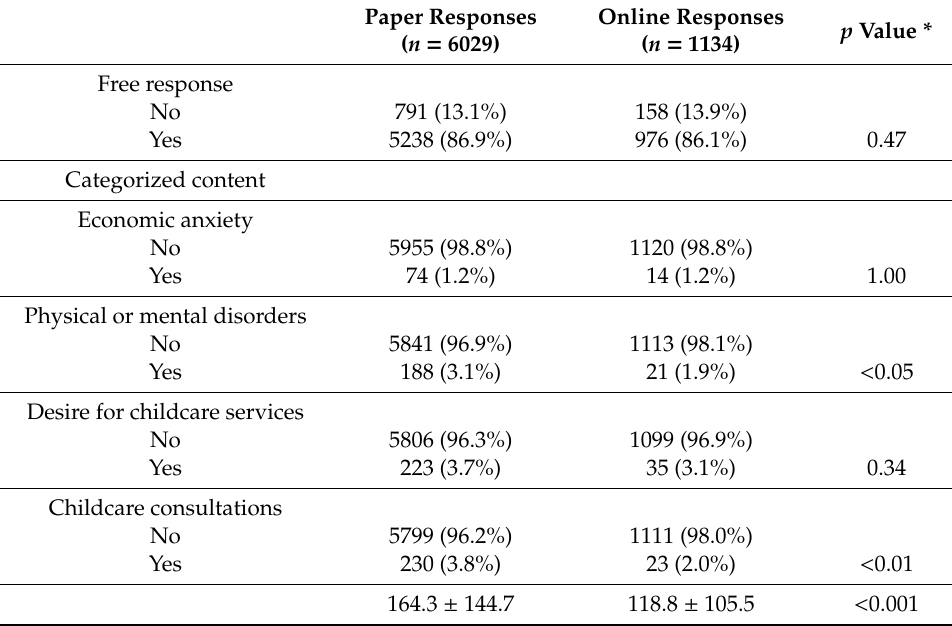
Table 3. Free responses: comparisons by survey